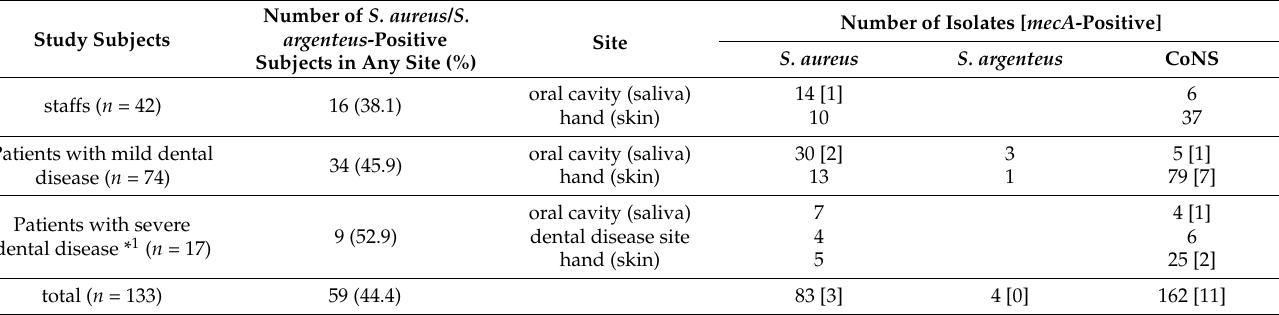
Table 1. S. aureus , S. argenteus and CoNS isolates from study subjects ( n =